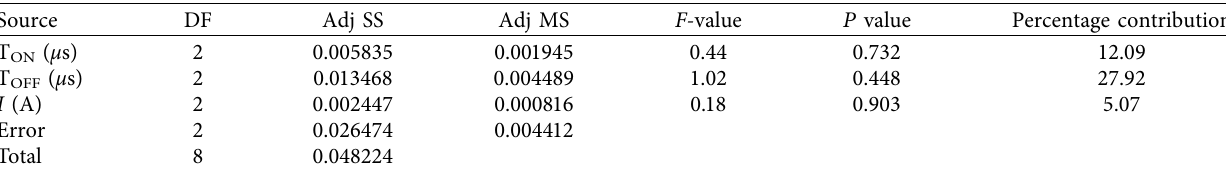
Table 4: Results of ANOVA for